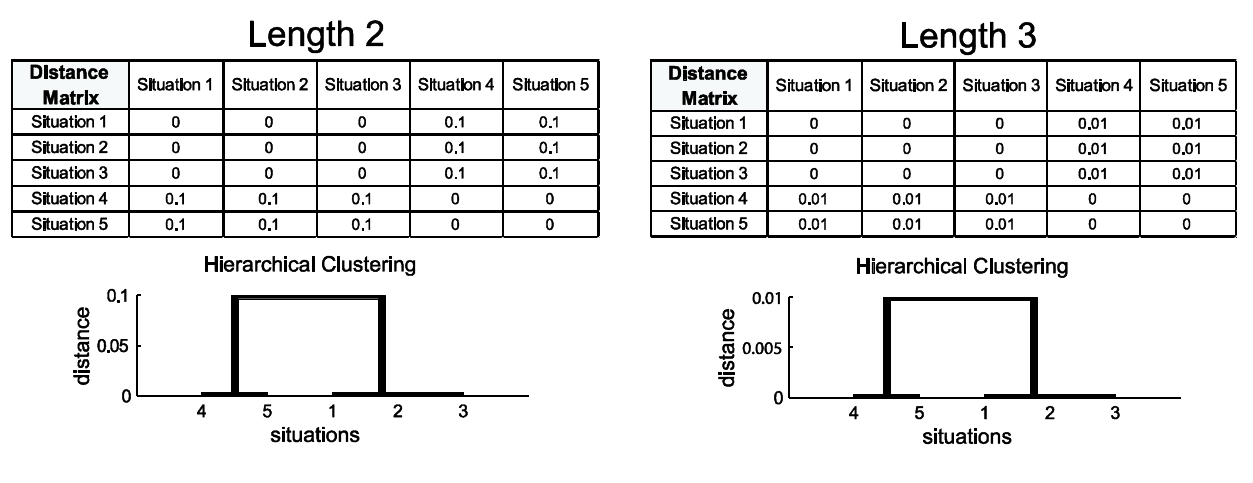
Figure 9. Distance matrices and hierarchical clustering of five traffic situations (five trajectory pairs) for SESIs of lengths 2 and 3 based on the distance function in Equation (6). Table 1 . QTC Movement patterns of the above five trajectory pairs between two cars, k and